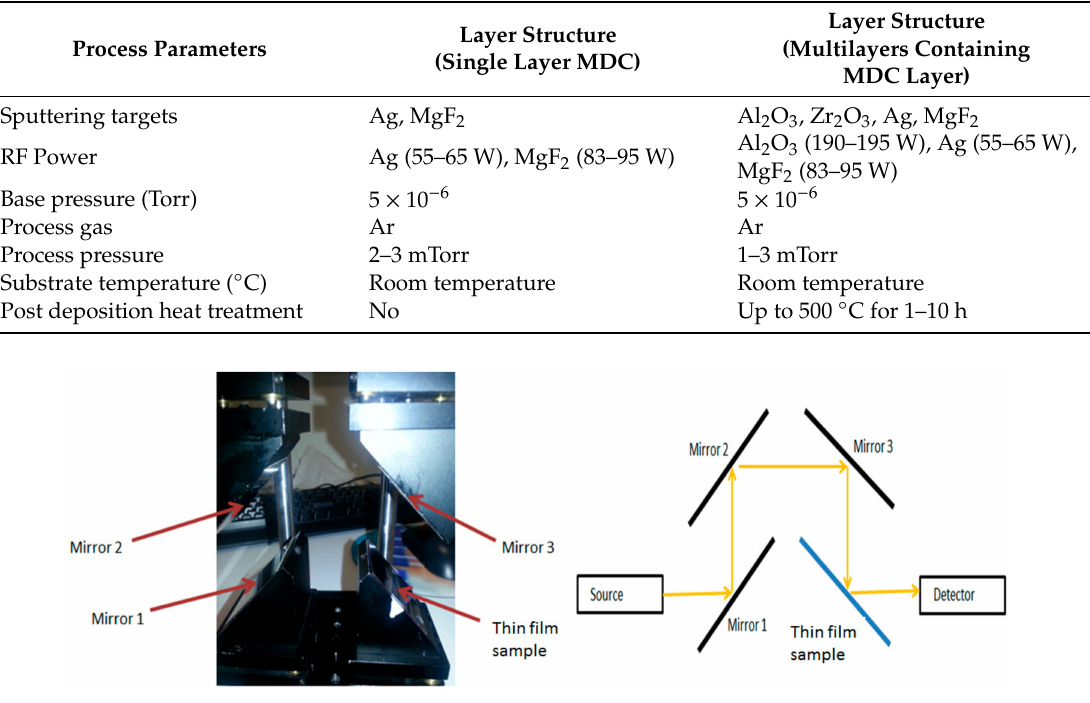
Table 2. Sputtering process parameters used to deposit metal–dielectric nanocomposite (MDC) single layer and MDC-containing multilayer building blocks.